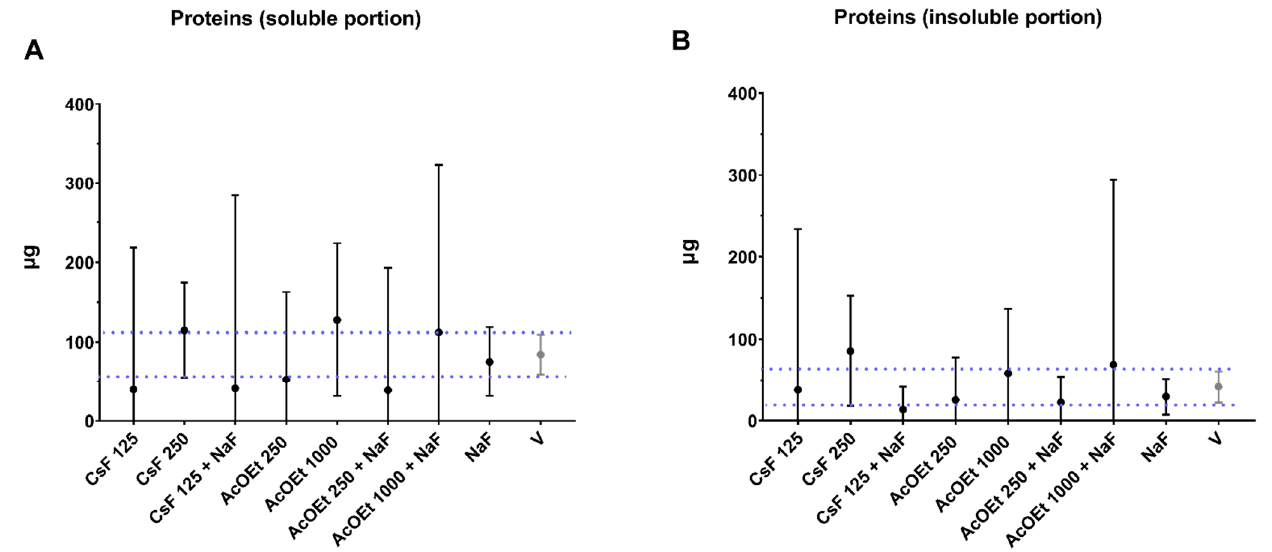
Figure A4. Total protein content (soluble and insoluble portions) of topically treated biofilms. The graphs show the total protein content in the soluble ( A ) and the insoluble portions ( B ) of topically treated biofilms. The central data are the mean, and the error bars are the confidence interval (95% CI). The blue dotted lines use vehicle data to compare the effectiveness of tested treatments. The vehicle control is represented as V (with the concentration being 21.04% EtOH and 3.75% DMSO for the AcOEt_BRA/DF fractions and 10.52% EtOH and 1.87% DMSO for CsF). The experiments for AcOEt_BRA/DF and CsF 125 µg/mL were performed in duplicate on one experimental occasion (n = 2) and in duplicate on two separate occasions (n = 4) for CsF 250 µg/mL.